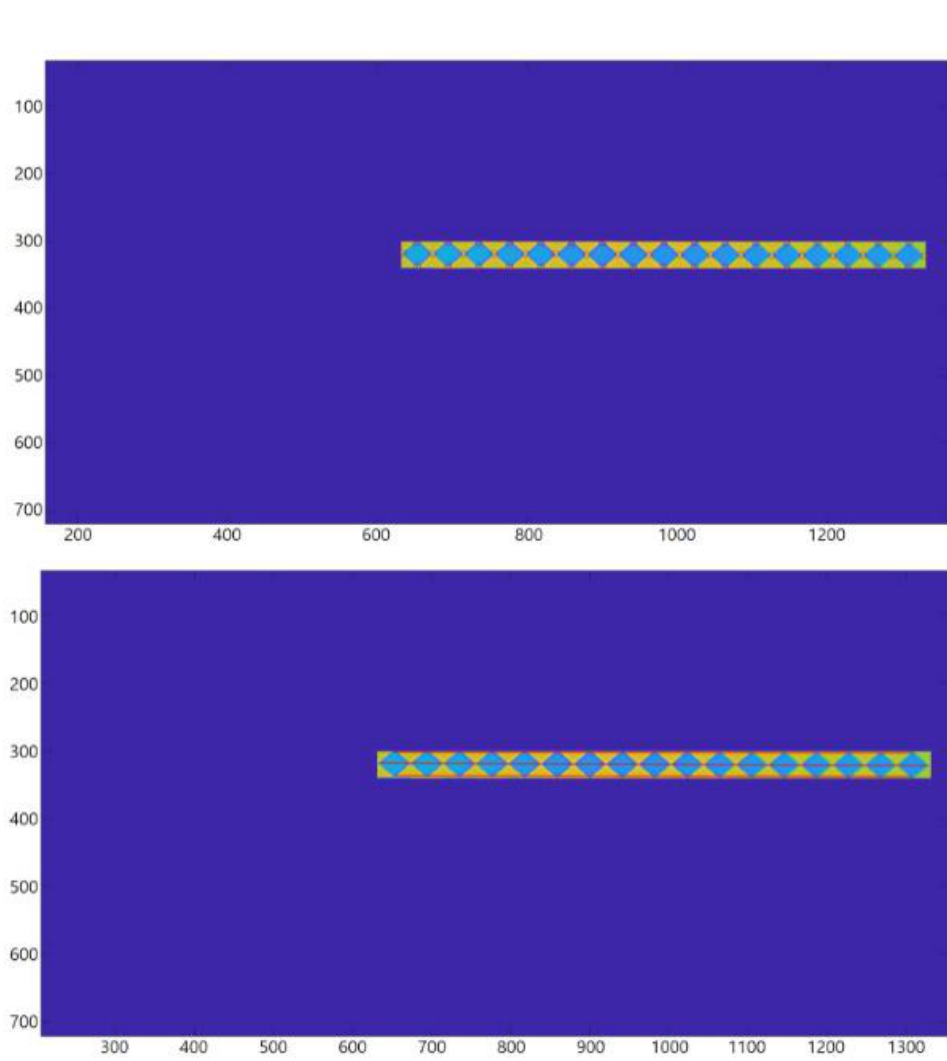
Figure 18. Diamond vertices extracted from the image ( top ), Straight line connecting diamond vertices ( bottom ).